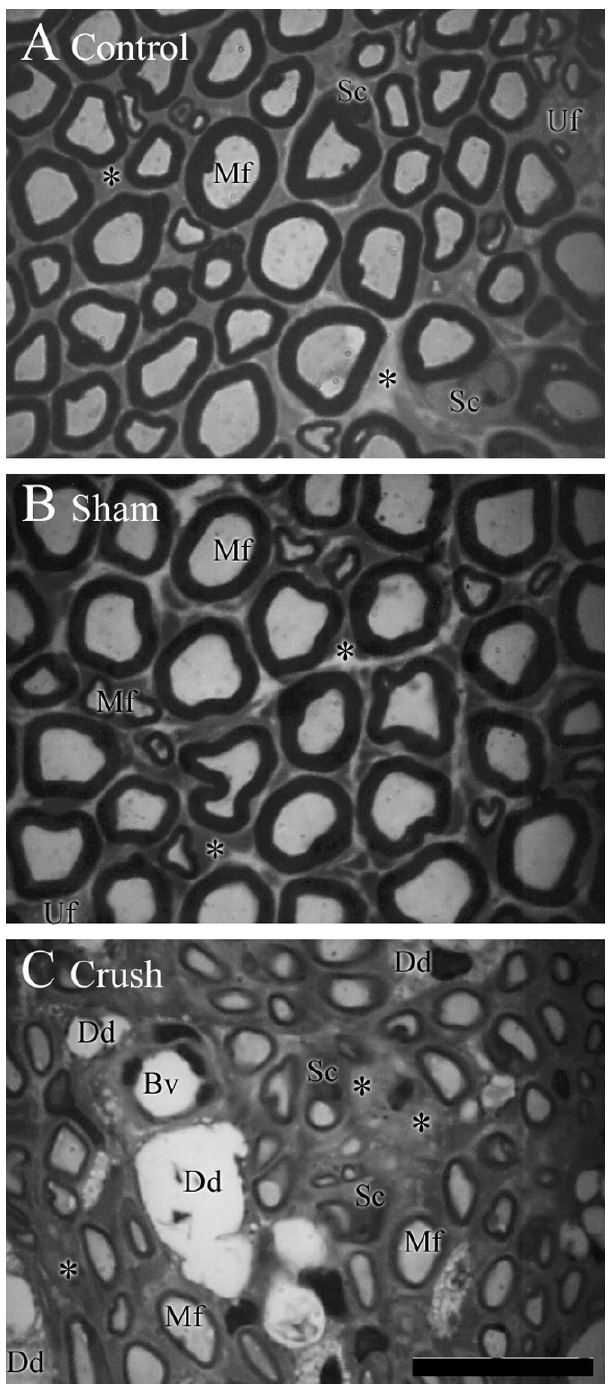
Figure 3 - Digitized images of transverse semi-thin sections (1 m m) obtained from regenerating sciatic nerves in control (A), sham (B) and crush (C) groups. Note the similarity and apparent bimodal fiber spectrum, the large and small myelinated fibers and the scanty endoneurial space between the myelinated fibers when clusters of unmyelinated fibers are present in the control and sham groups. Moreover, note that the crush group shows an apparent unimodal fiber spectrum with a predomi- nance of small-diameter thin myelin sheath fibers and an increased size of the endoneurium between the nerve fibers and the presence of degeneration debris in this group. Mf indicates myelinated nerve fiber; Uf, unmyelinated nerve